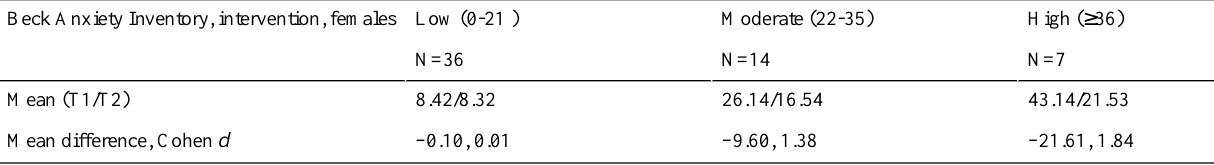
Table 11. Analysis of Beck Anxiety Inventory categories: female.